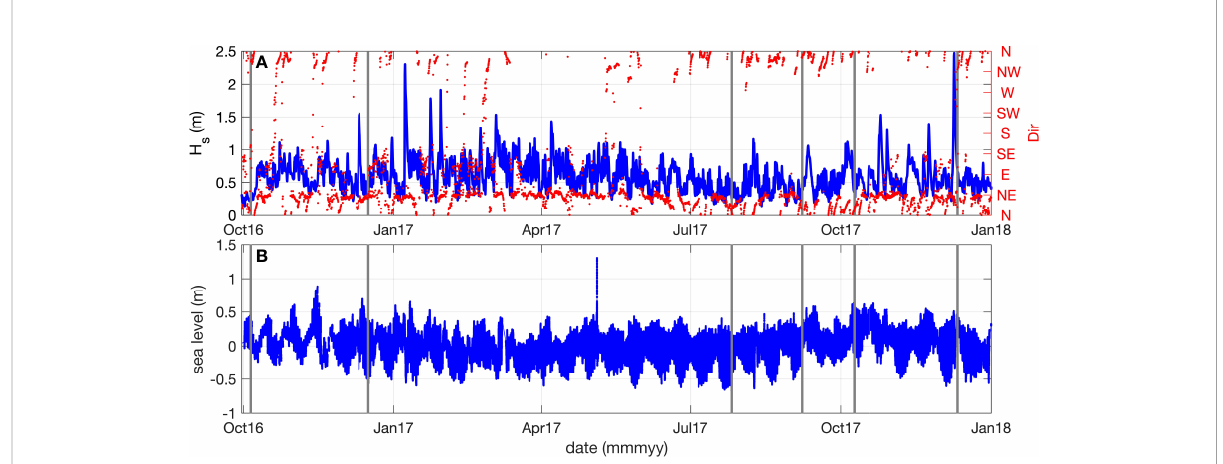
FIGURE 3 Wave and tide conditions in the study area: (A) signi fi cant wave height -blue line- and mean wave direction -red dots-; (B) sea level. Grey lines denote the dates of the UAV fl